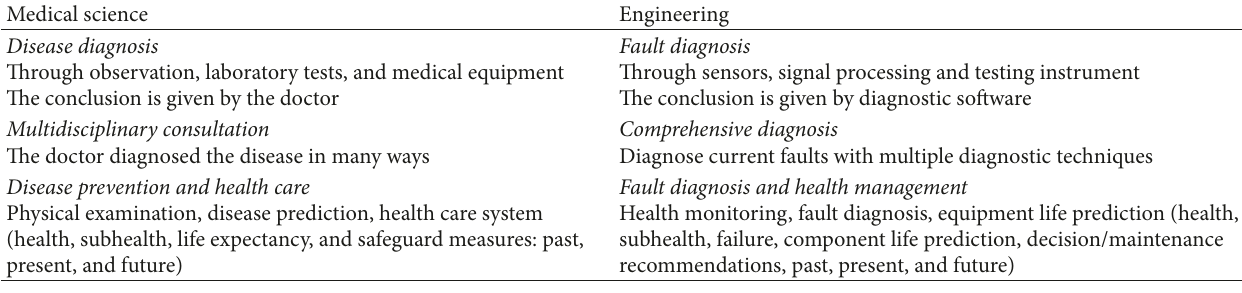
Table 1: Analogy of fault diagnosis in biology and engineering.